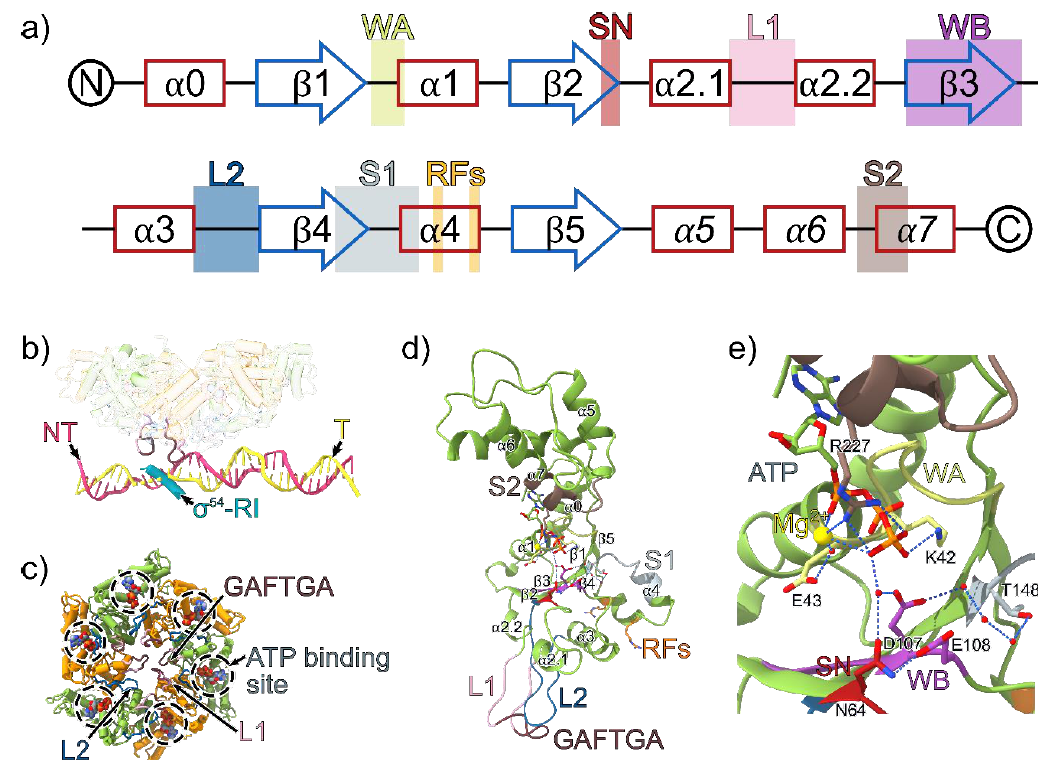
Figure 3. ( a ) The secondary structure of clade 6 AAA + proteins with the positions of the conserved AAA + motifs indicated. α helices are shown in red and β sheets are shown in blue. The α-helices in the lid subdomain are italicised. WA = Walker A, SN = Switch asparagine, L1 = Loop 1, WB = Walker B, L2 = Loop 2, S1 = sensor 1, RF = R fingers, S2 = Sensor 2. ( b ) The phage shock protein F (PspF) hexamer, σ 54 region I (RI) and promoter DNA from the RPi structure (PDB ID: 5NSS). The highly conserved GAFTGA motif on the L1 loop projects downward from the plane of the PspF ring and contacts σ 54 -RI and the −11/−12 region on the promoter DNA. PspF monomers in the ring are coloured in green and orange; template strand (T), yellow; non-template strand (NT), pink; σ 54 -RI, cyan. ( c ) The PspF AAA + domain hexamer from the viewpoint of the promoter DNA. ATP molecules are superimposed on the structure based on the ATP bound PspF crystal structure (PDB ID: 2C96). ( d ) PspF monomer model based on the crystal structure of an individual monomer of the AAA + domain of PspF bound to ATP (PDB ID: 2C96). The solvent and magnesium atoms are superimposed from the ATP-bound PspF R227A AAA + domain (PDB ID: 2C9C), and the missing parts of the L1 and L2 loops are modelled from the ATP bound structure of NtrC1 E239A AAA + domain (PDB ID: 3M0E). ( e ) The ATP binding site interactions within a PspF monomer.